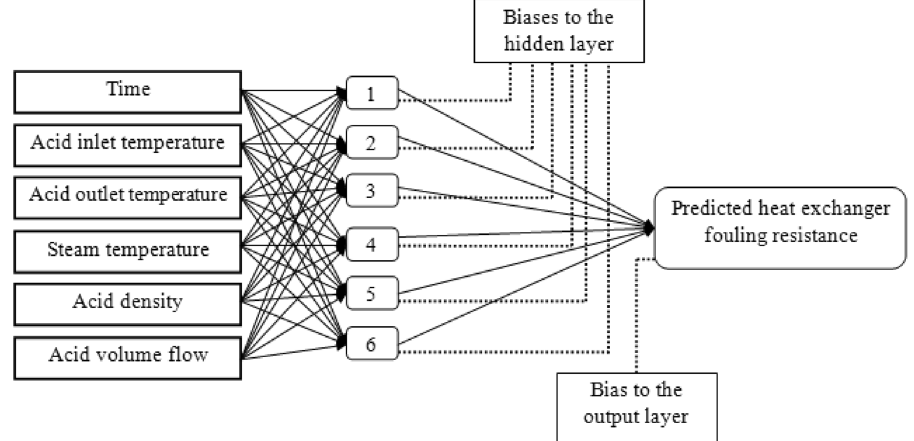
Figure 4. The optimal ANN configuration.